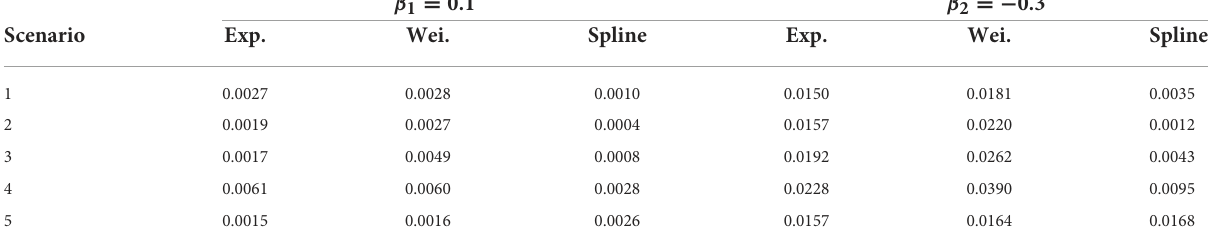
TABLE 2 Mean square error relative to CPH model